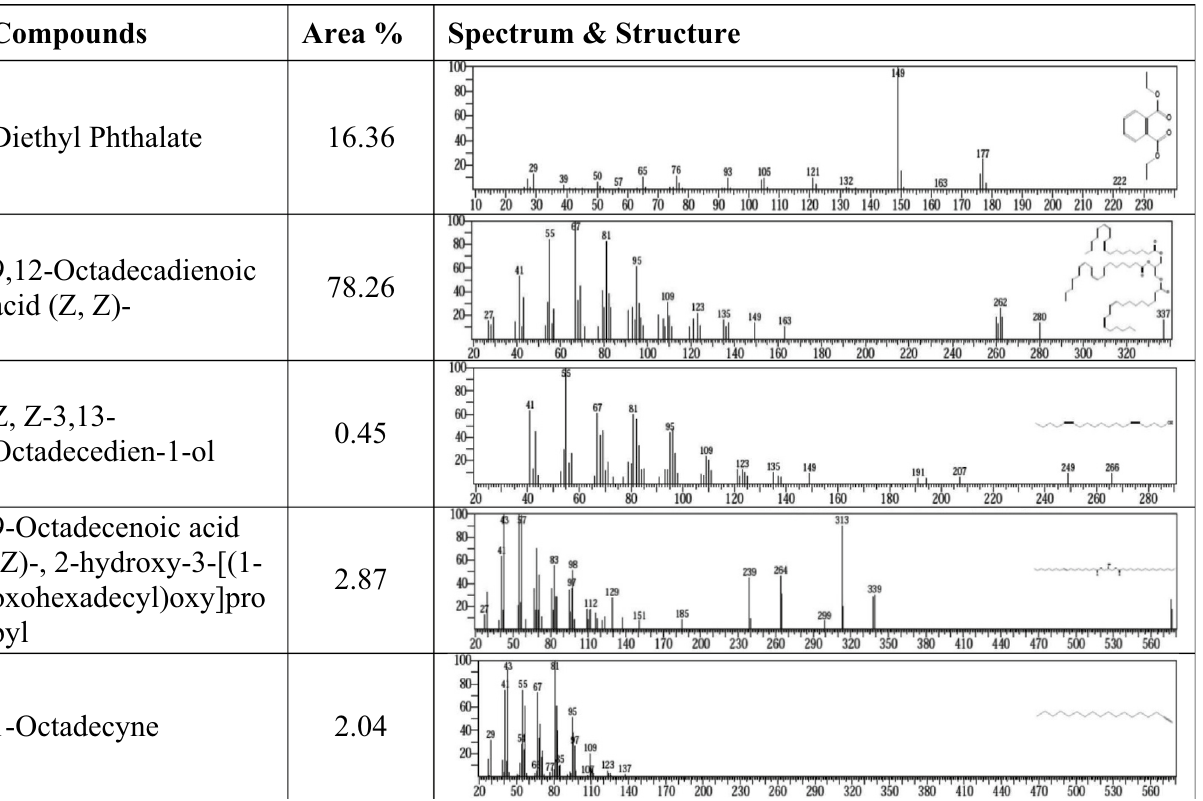
Figure 10. GC–MS analysis of lipids produced by Scenedesmus obliquus after methyl red decolorization.